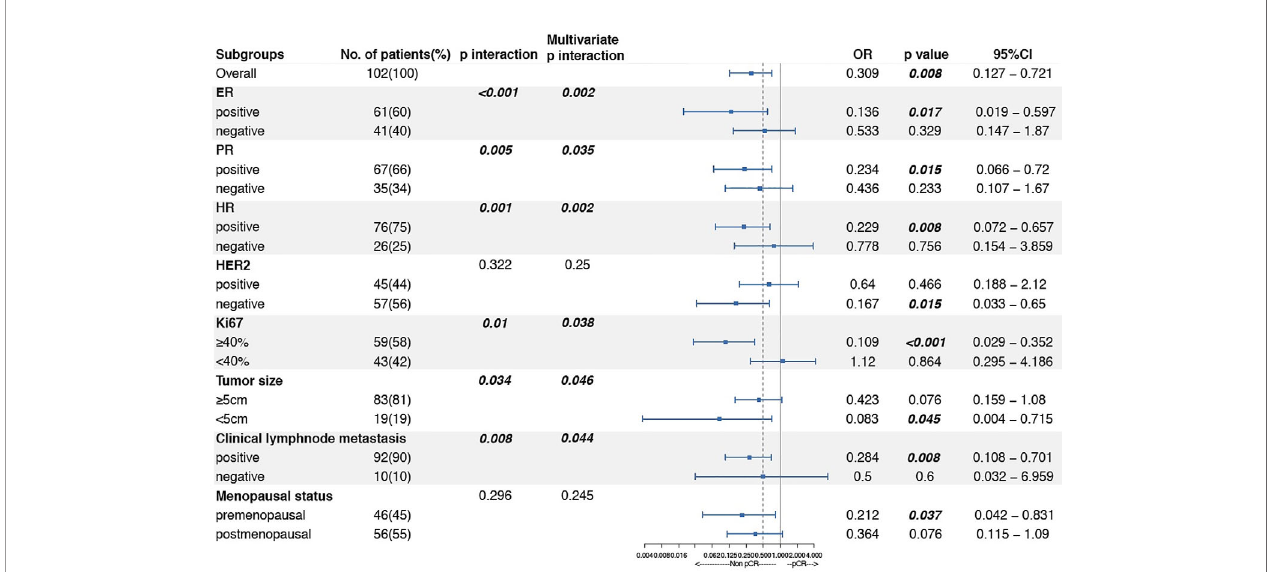
FIGURE 2 | Subgroup analysis and interaction analysis between Linc00665 and clinicopathological factors regarding pCR after